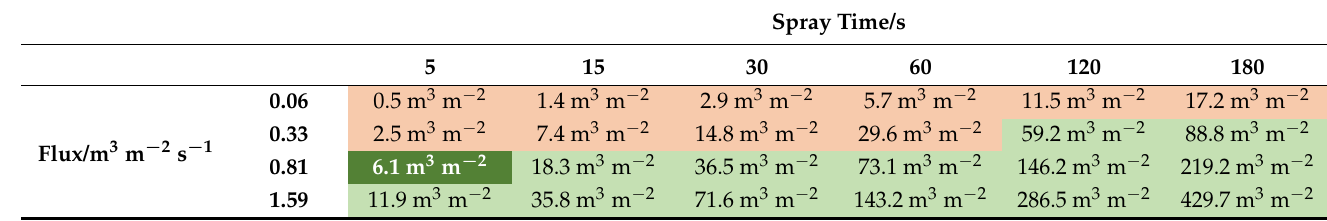
Table 6. Water demand per square meter for all back-wash cleaning parameter combinations. The color background is based on the cleaning performance. A cleaning above the threshold of a one-hundred-fold increase in flow in relation to the blinded cloth is marked in green and insuf- ficient regeneration in red. Highlighted in dark green is the successful combination with the lowest water demand.